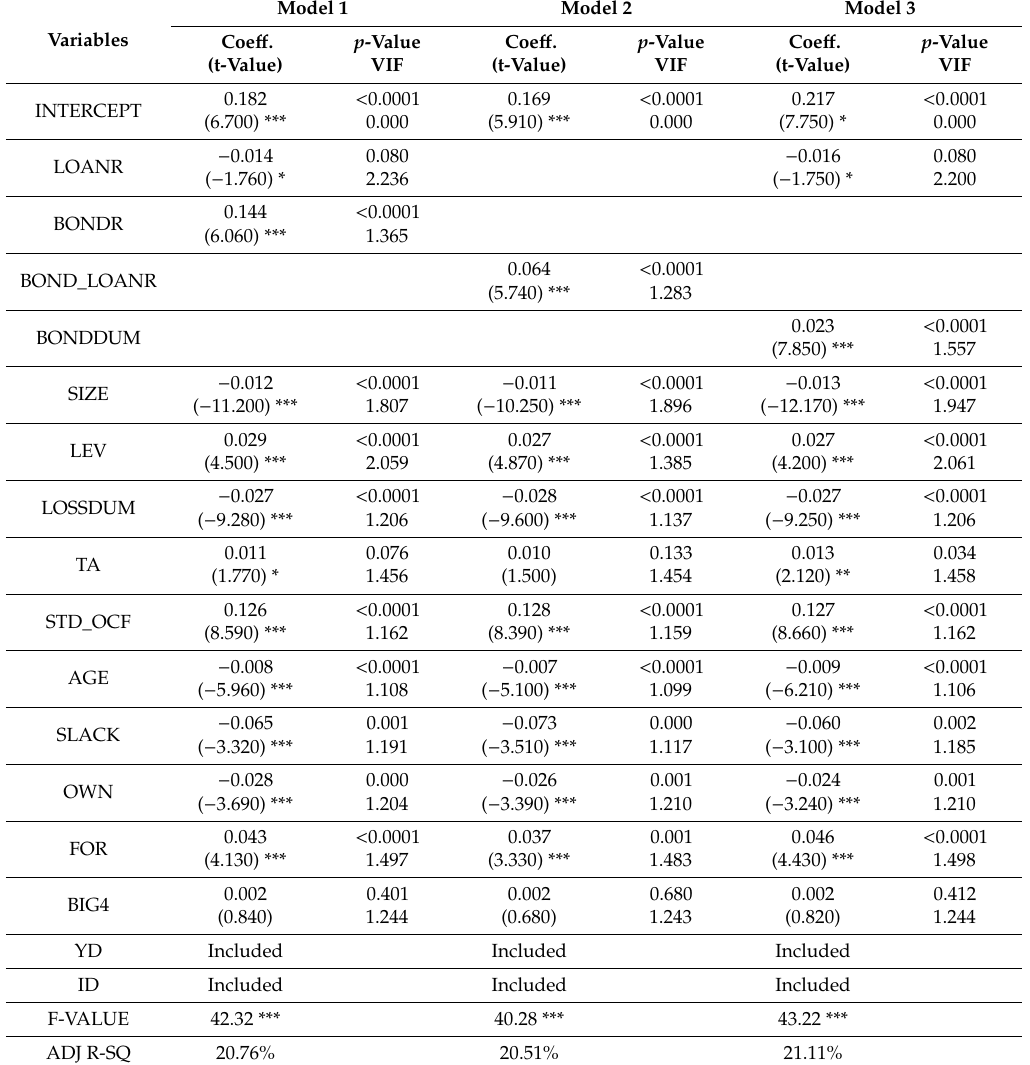
Table 7. Debt origin and investment e ffi ciency: underinvestment sample (n =